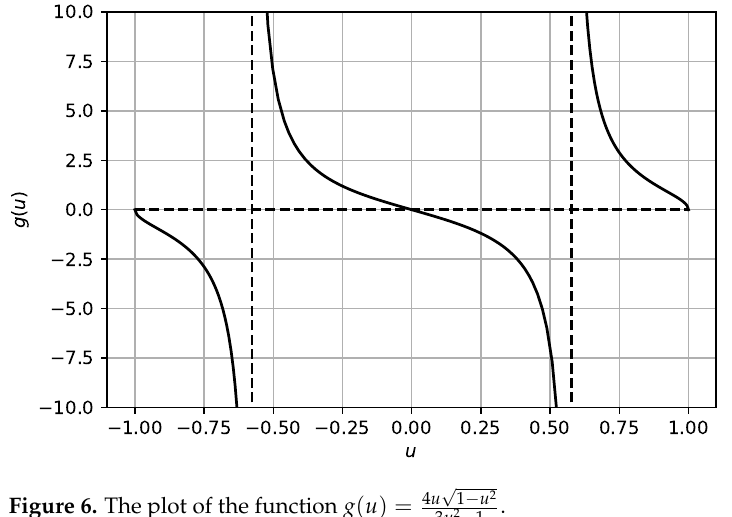
Figure 6. The plot of the function g ( u ) = 4 u